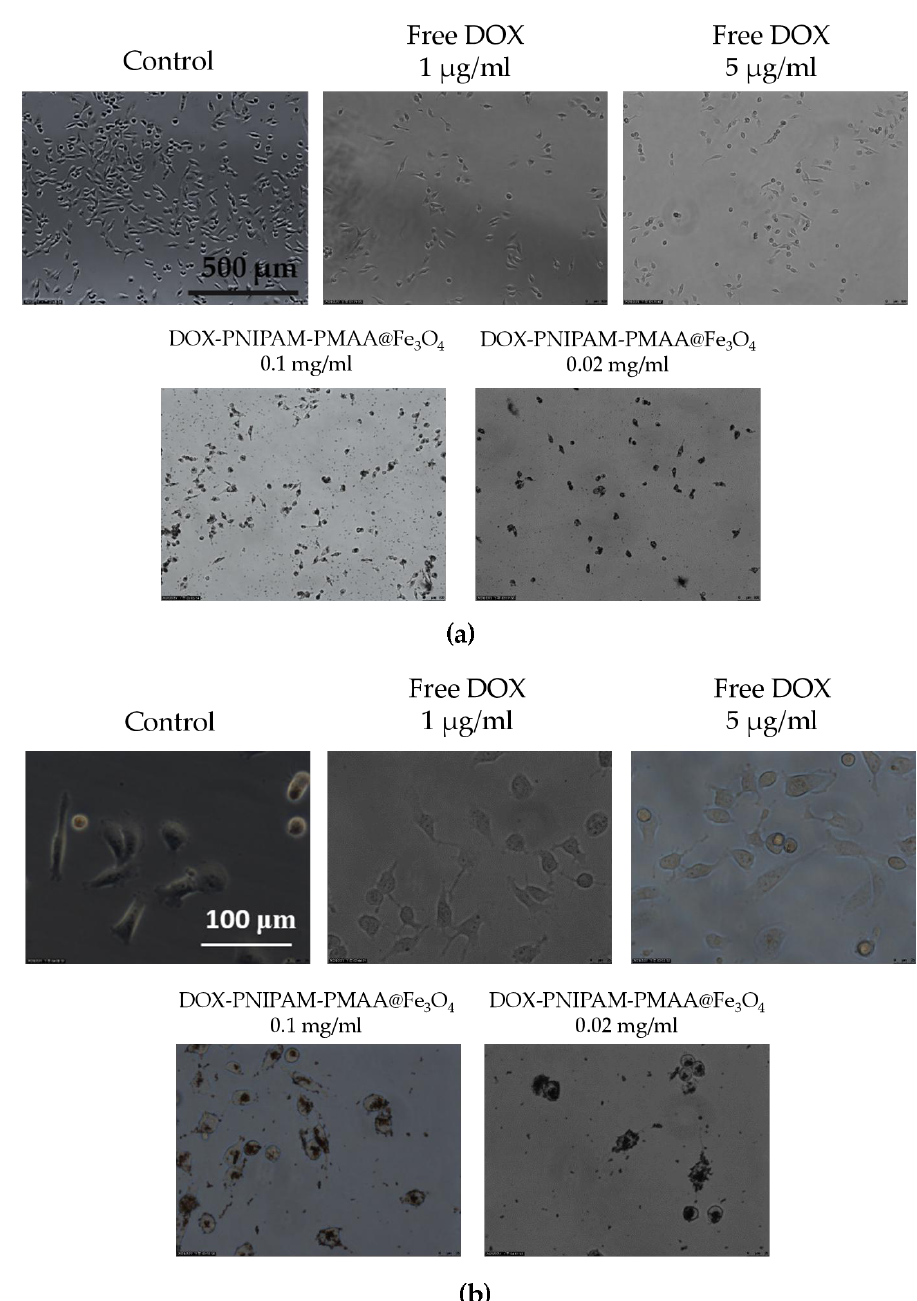
Figure 8. Cellular uptake analysis via microscopy. ( a ) Comparison of particle treatments under bright field observation (100×). ( b ) Comparison of particle treatments under bright field observation (400×).